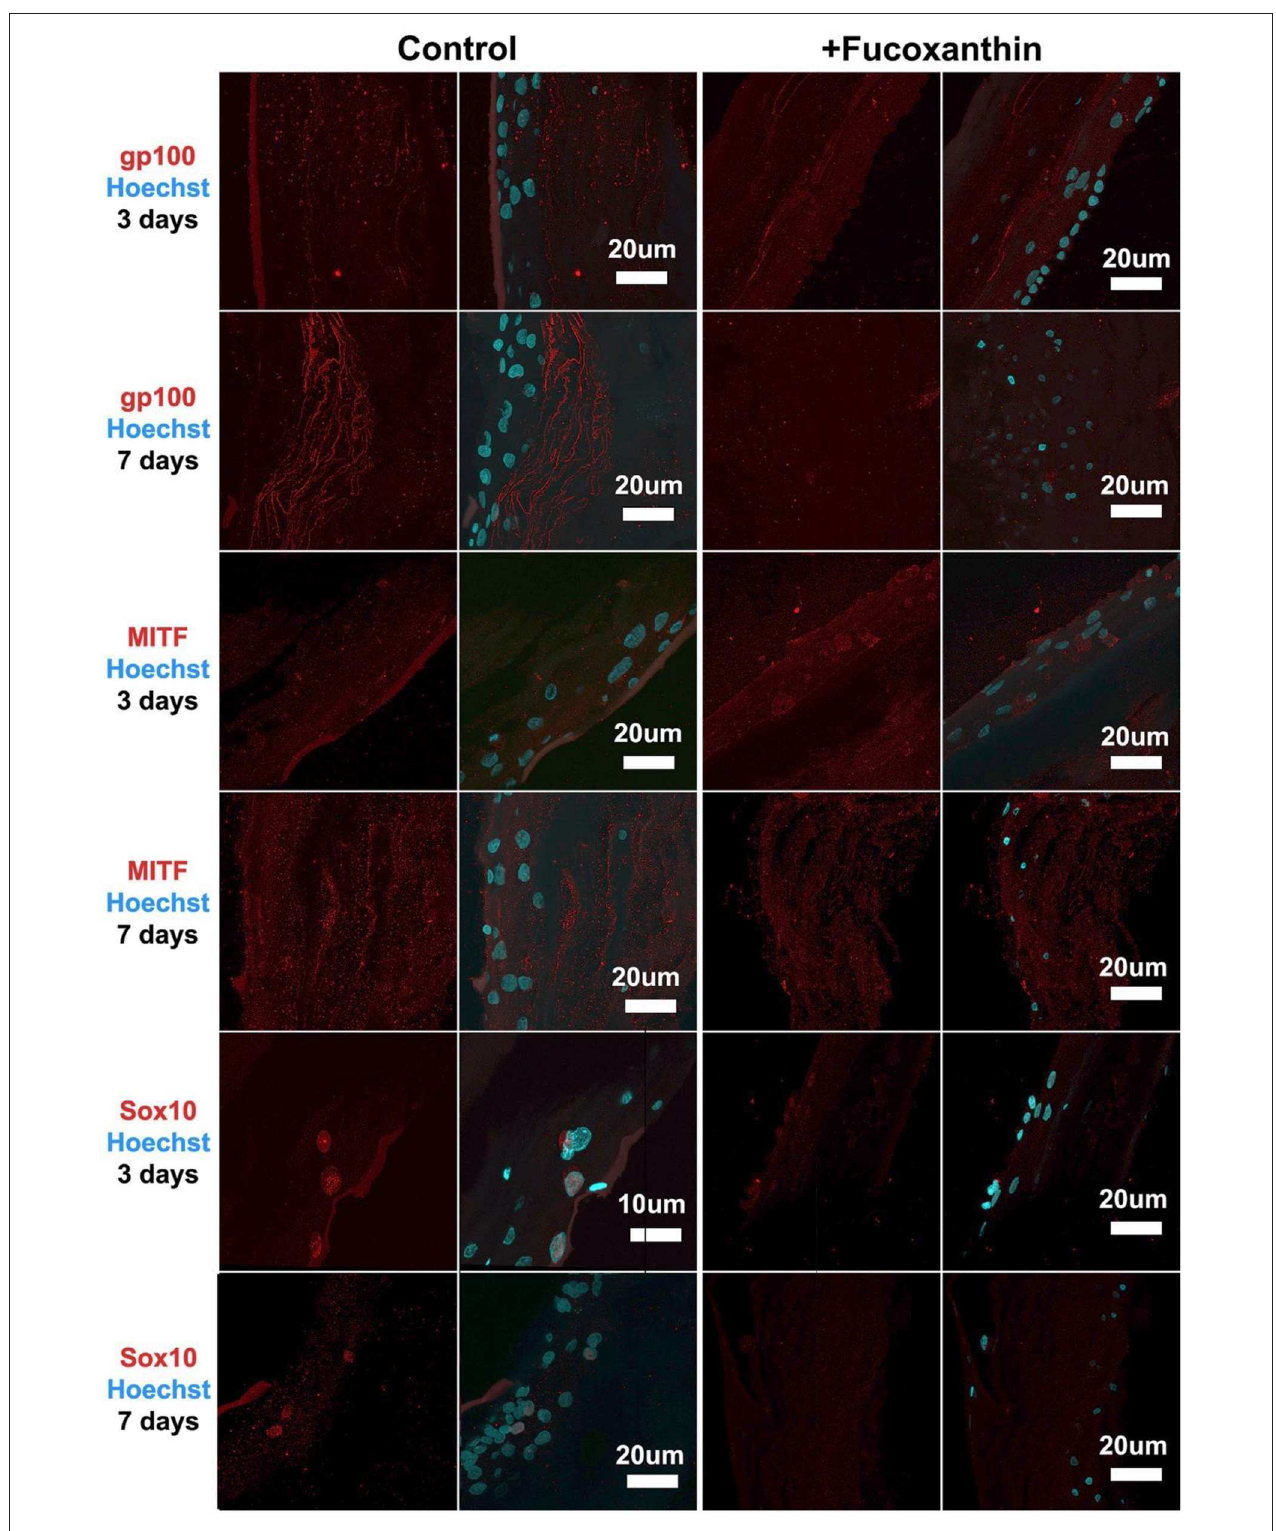
FIGURE 4 | Immunocytochemical analysis of gp100, MITF, and Sox10 (red) expression on sections of MelanoDerm TM tissue equivalents in the control and experimental groups on Days 3 and 7 of cultivation. The nuclei are stained with Hoechst 33258 (blue). Laser-scanning confocal microscopy.